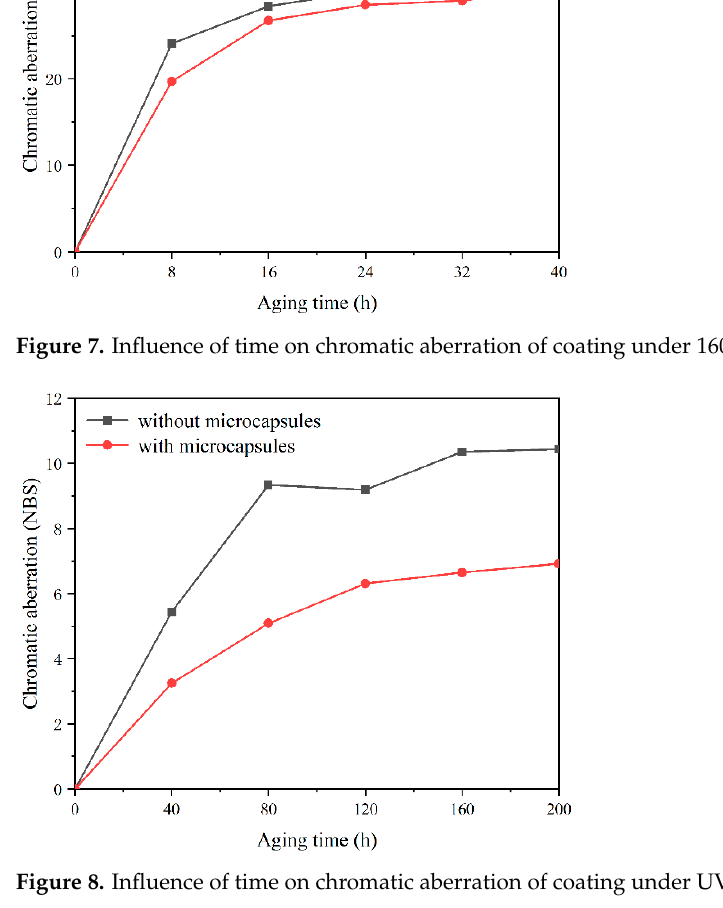
Figure 8. Influence of time on chromatic aberration of coating under UV weather resistance test.